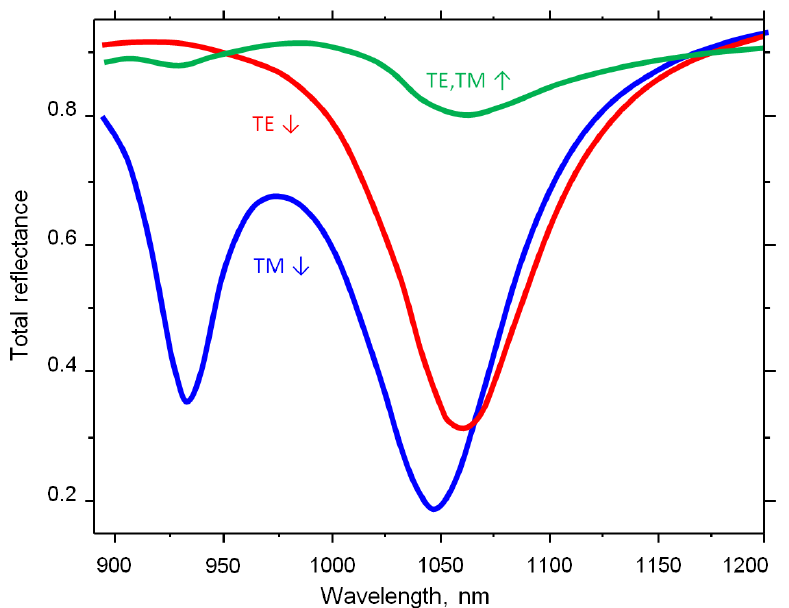
Figure 3. Spectral reflectance of the structure with embedded blazed grating shown in Figure 1b with MXene coating; blue line: normal incidence from the top, TM polarization; red line: normal incidence from the top, TE polarization; and green line: normal incidence from the bottom for both polarizations (TE = TM).